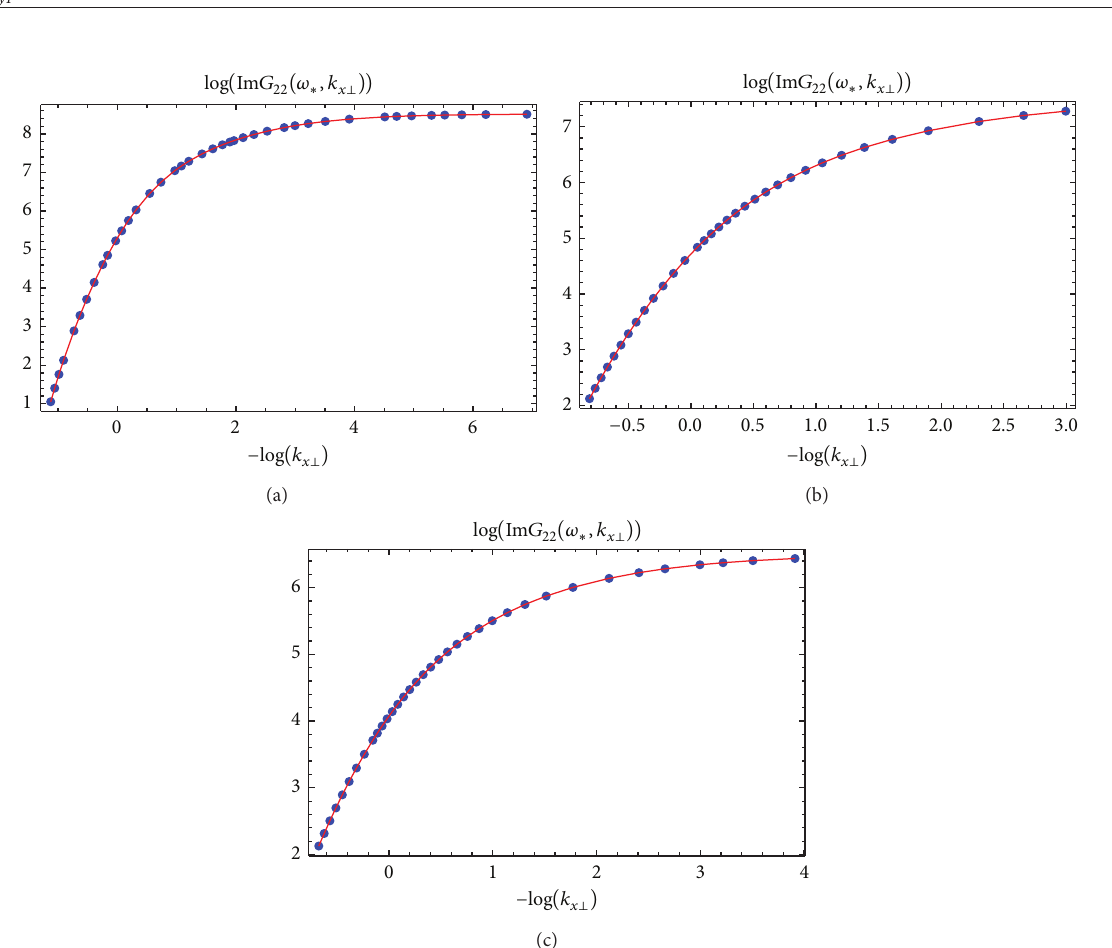
Figure 5: The scaling relation of the logarithm of the height of Im 𝐺 22 (𝜔 ∗ (𝑘 𝑥⊥ ),𝑘 𝑥⊥ ) at the maximum for 𝑎 2 = 0.01 (a), 𝑎 2 = 0.04 (b), and 𝑎 2 = 0.09 (c).